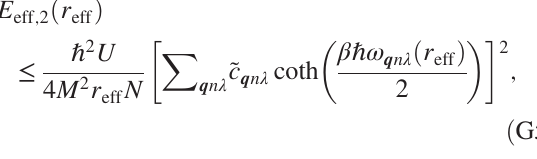
FIG. 14. Softening of the phonon mode relevant to the para- electric-to-ferroelectric phase transition, which is labeled as the RTM 0 mode in Fig. 6. The solid colored curves represent the in- plane dispersions of the softened phonon mode with decreasing the insulator thickness d from top to bottom curves. Each dispersion is obtained by setting the phonon-frequency parameter Ω 2 equal to the effective value r (cid:2) determined from the eff variational analysis for each thickness [cf. Fig. 8(a)]. The black dashed line represents the effective phonon frequency in the bulk 5 , U ¼ 1 , g ¼ 3 . 5 , and case. We set c ¼ ℏ ¼ β ¼ 1 , ω p ¼ Λ 10 2 . The tuning parameter is fixed to be r ¼ − 45 . From c ¼ top to the bottom solid curves, the thickness is varied from d ¼ 4 to d ¼ 1 with step δ d ¼ 1